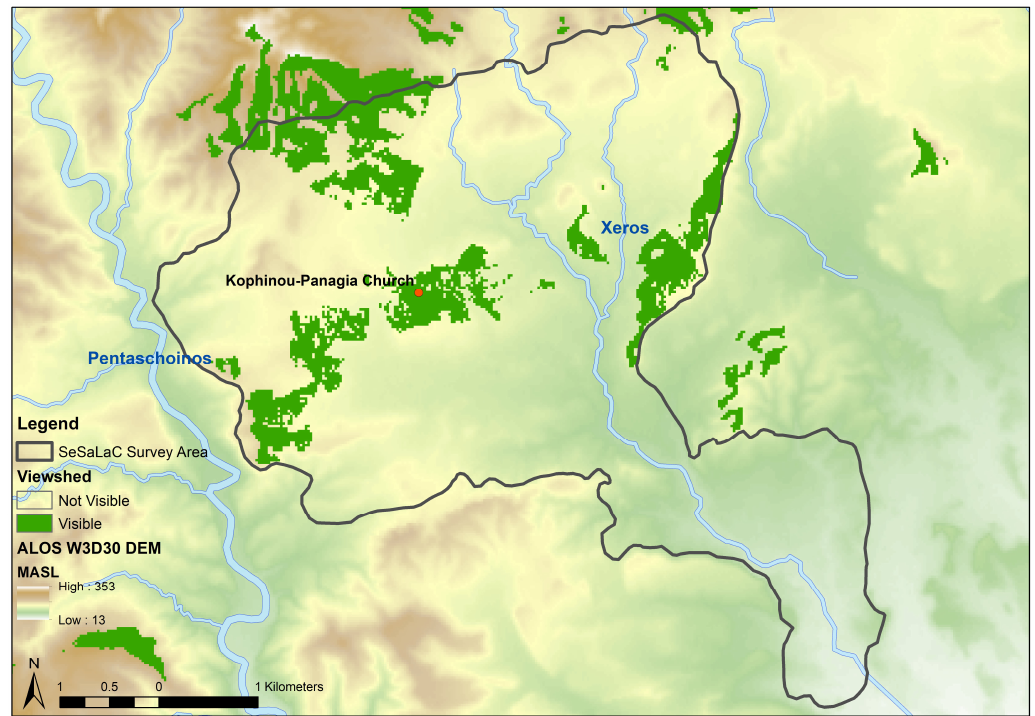
Figure 27. Viewshed Analysis from the Late Antique site of Kophinou-Panagia at the centre of the Xeros River valley. To create the Viewshed (at 1.8 m above ground), certain factors (such as the potential existence of tall trees and high buildings) cannot be taken into account due to the lack of evidence for pre-modern vegetation and land-use. Digital data courtesy of the Geological Survey Department, Republic of Cyprus (GIS analysis by Charalambos Paraskeva).